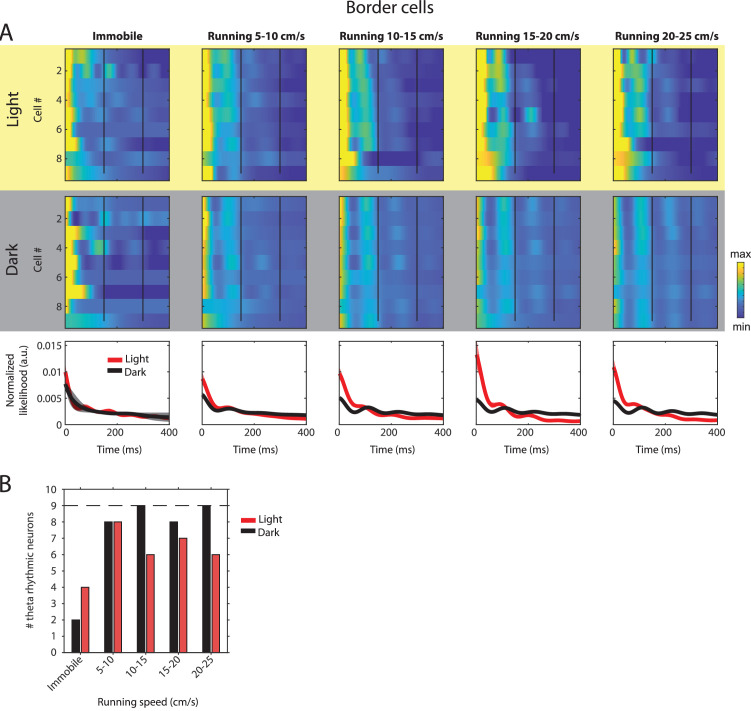
Changes in theta rhythmic firing as a function of running speed and visual inputs in theta rhythmic border cells.Red color or yellow background indicates data on the light condition, black and gray color or gray background indicates data on the dark condition. (A) Upper panels show the color coded MLE autocorrelogram models for each of n = 9 theta rhythmic border cells at different running speed intervals. Immobility was defined as running speed <3 cm/s. Neurons are sorted per condition in order of their theta rhythmic firing frequency. Bottom row shows the average across autocorrelogram models per condition. (B) Number of neurons shown in A with statistically significant spiking rhythmicity at alpha = 0.1 determined by the MLE model for different running speeds in light and dark. A longitudinal analysis of changes in frequency or magnitude of theta rhythmic firing as a function of running speed could not be performed because the number of neurons with significant theta rhythmic modulation across all running speed bins was smaller than three in light and dark conditions.